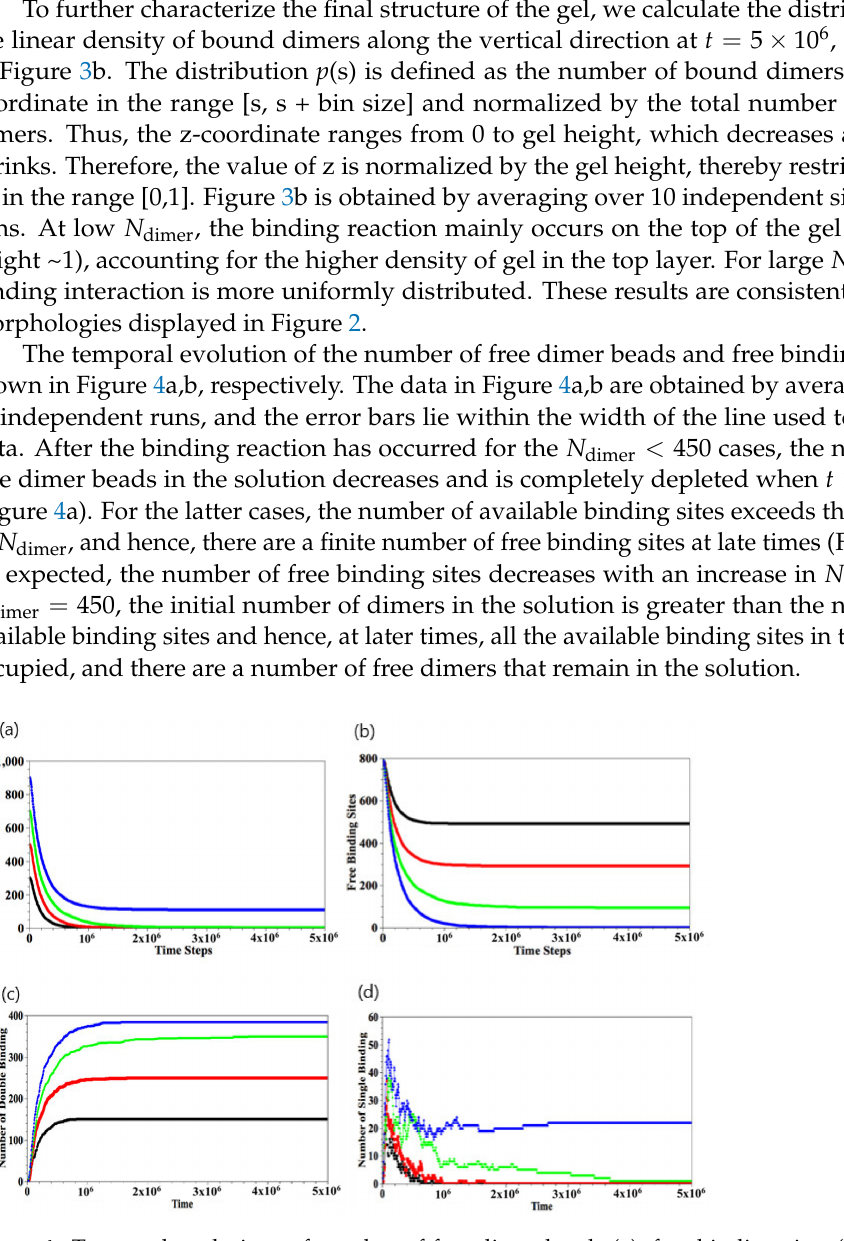
Figure 4. Temporal evolutions of number of free dimer beads ( a ), free binding sites ( b ), double binding ( c ), and single binding ( d ), respectively. Here, N dimer = 150 (black), 250 (red), 350 (green), and 450 (blue). Error bars in ( a,b ) are within the width of the lines used to plot the